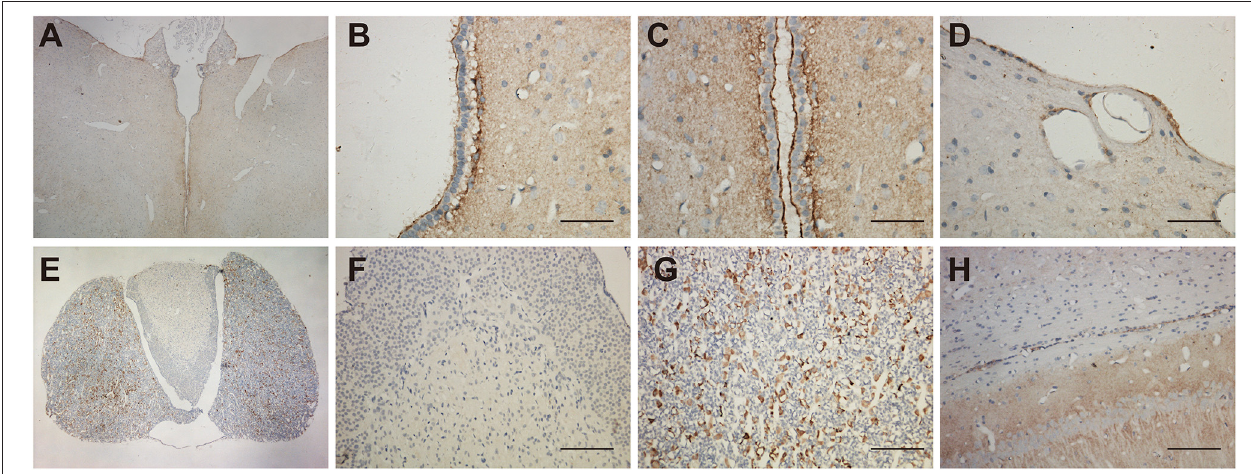
FIGURE 2 | Distribution of UT-B in the third ventricular and neurohypophysis by immunohistochemistry. (A) UT-B was expressed around the third ventricular wall. (B,C) High magnification view of the third ventricle, strong UT-B labeling is present in the subependymal glia limitans, and free surface of ependymal cells. (D) Cerebral pia mater. (E) Low magnification of the hypophysis illustrating that UT-B is only expressed in the adenohypophysis. (F) High magnification view of the neurohypophysis. (G) High magnification view of the adenohypophysis. (H) UT-B by glial cells in white-matter fiber tracts. Scale bar, 200 µ m. UT-B, urea transporter